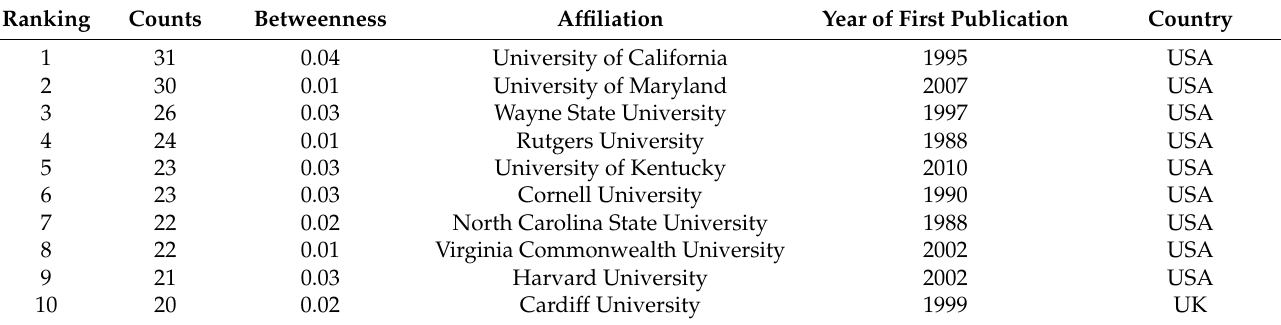
Table 4. Top 10 most productive institutions for crisis and risk communication